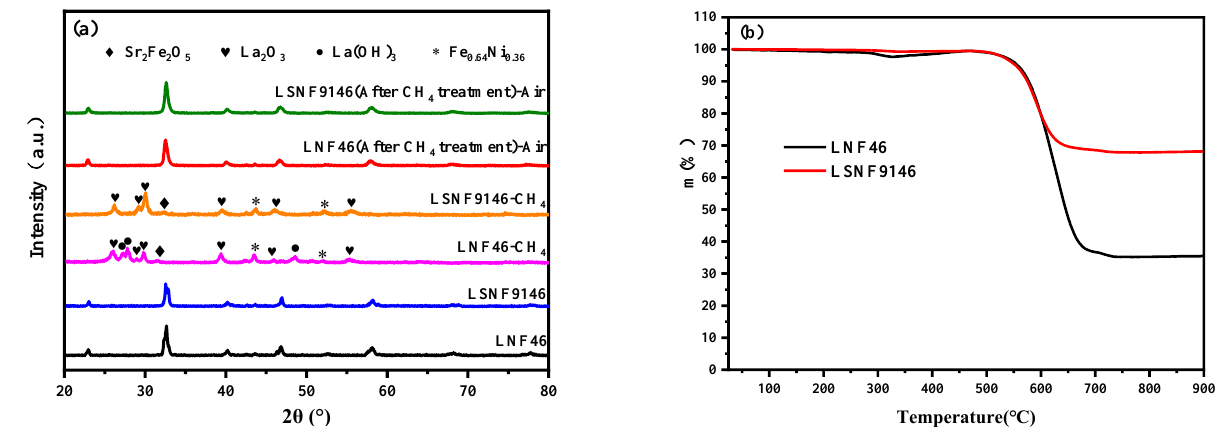
Figure 4. ( a ) XRD spectra of La 1-x Sr x Ni 0.4 Fe 0.6 O 3- δ (x = 0.00, 0.10) after treatment under different